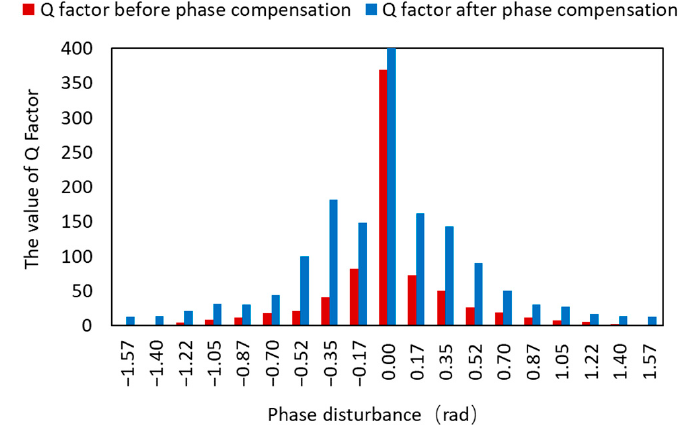
Figure 14. Q factors before and after phase compensation.